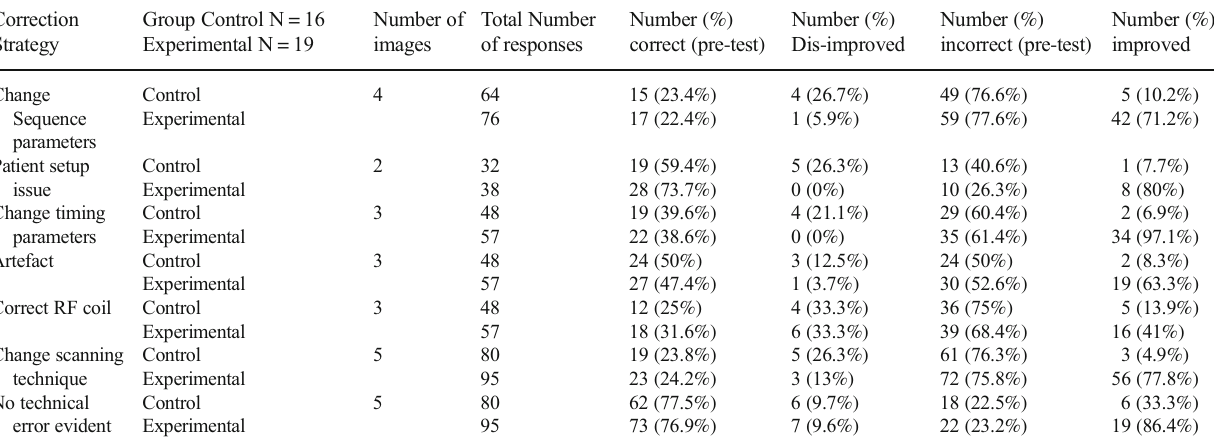
Variation in radiographer responses in specifying the appropriate error-correction strategy for MR image-quality errors Correction Group Control N = 16 Strategy Experimental N = 19